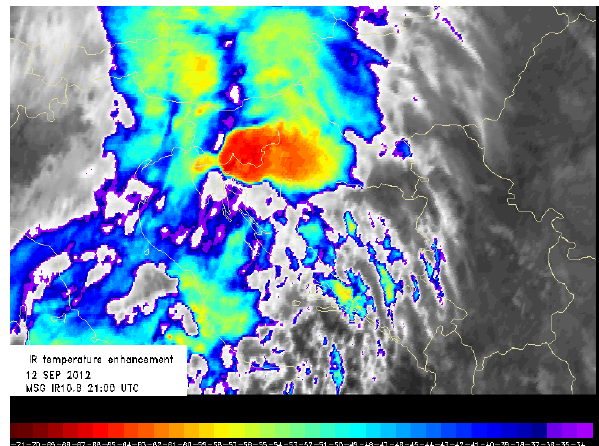
Figure 13. IR temperature enhanced satellite image for 21:00UTC on 12 September 2012, which was the operational MSG product used in DHMZ at the